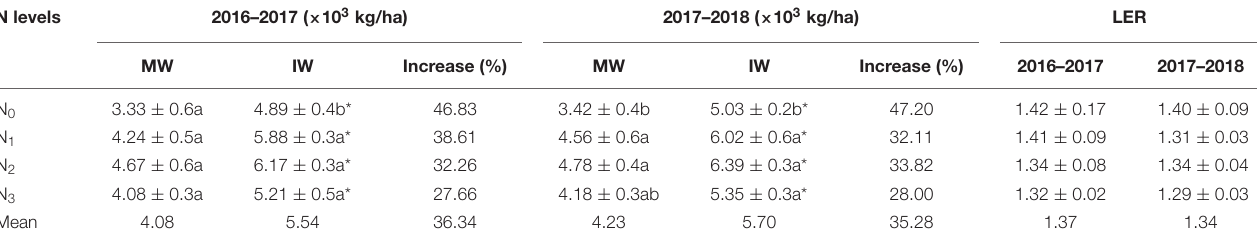
TABLE 5 | Effects of applied nitrogen and intercropping on wheat yield and LER. N levels